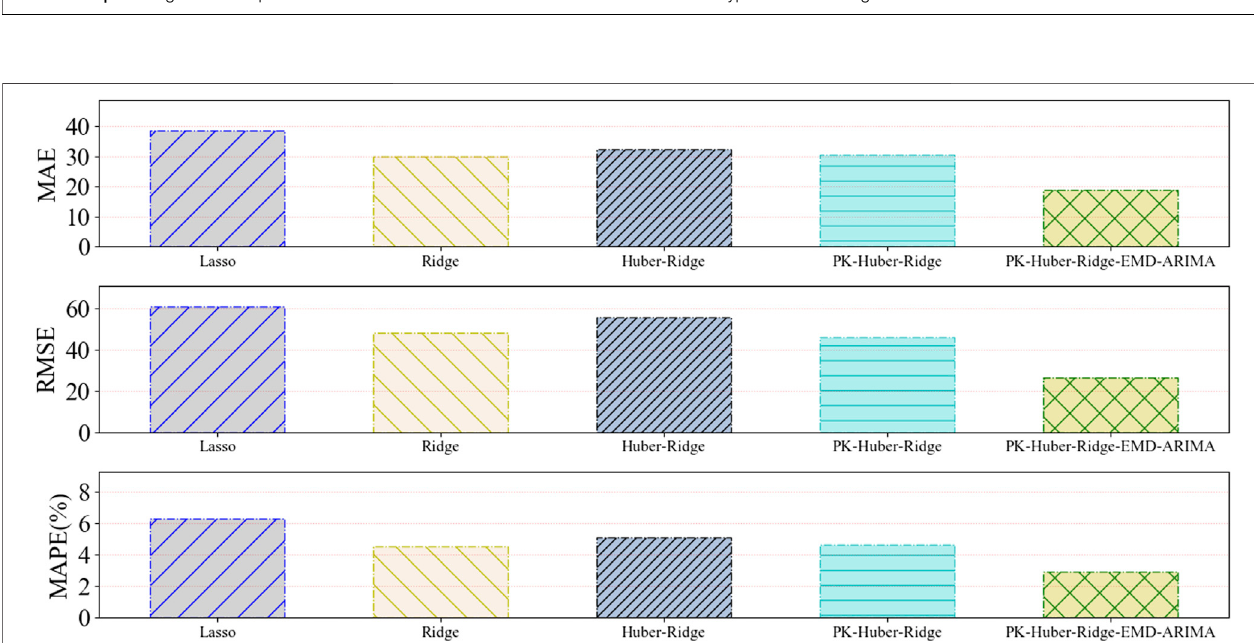
FIGURE 4 | A histogram of the predictive evaluation index values based on dataset 2 for fi ve types of forecasting models.